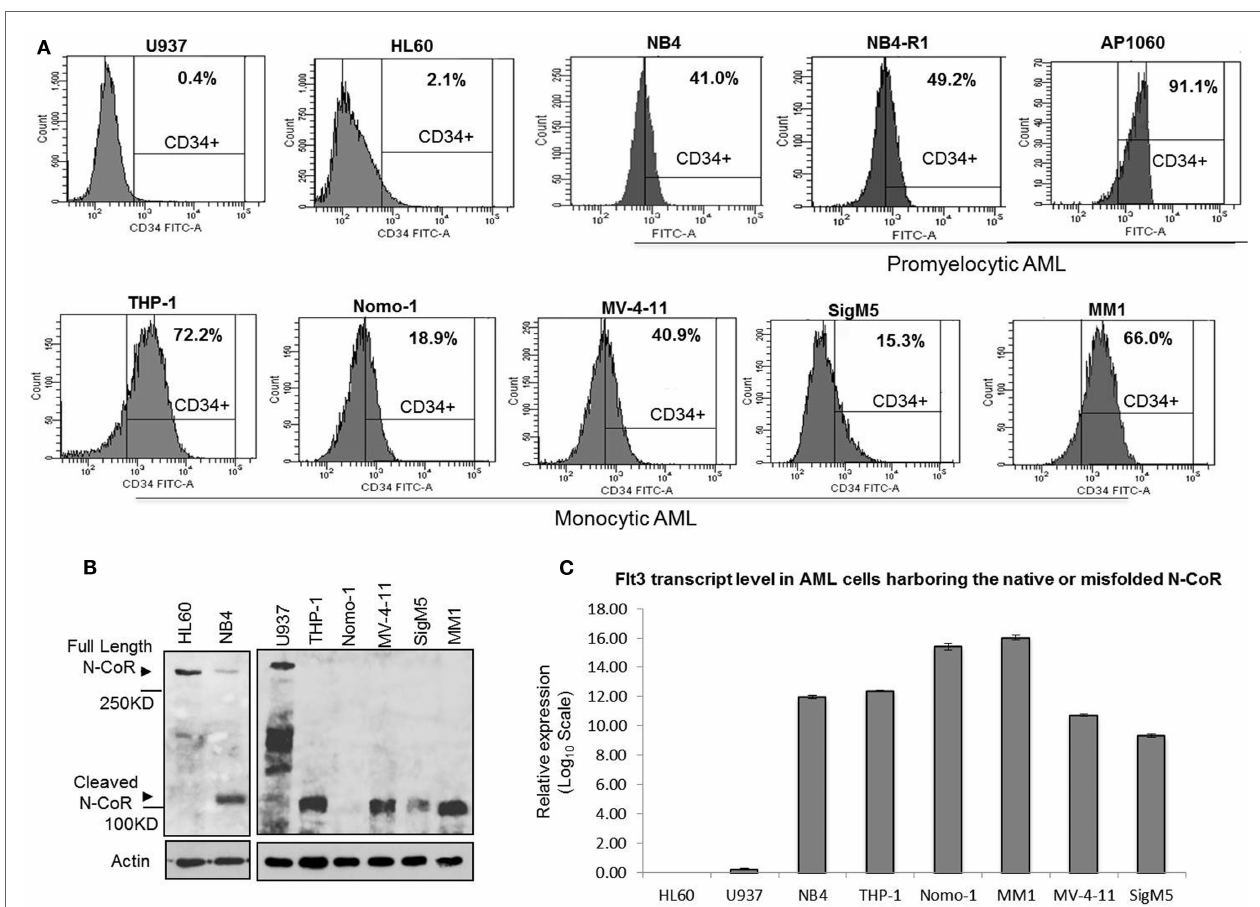
FigUre 4 | Misfolded n-cor is correlated to the cD34 + /Flt3 + -based stem cell phenotype in promyelocytic and monocytic aMl-derived cells . (a) Percentage of CD34 + cells in promyelocytic AML (NB4, NB4-R1, and AP1060) or monocytic AML (THP-1, Nomo-1, MV-4-11, SigM5, and MM1) as well as non-promyelocytic/monocytic AML cells (HL-60 and U937) as determined by flow cytometry. (B) An aliquot of whole-cell extract prepared from various AML-derived cells as mentioned on the top of each lane was resolved in SDS-PAGE and stained with anti-N-CoR antibody. All the CD34 + promyelocytic and monocytic AML cells (NB4, THP-1, Nomo-1, MV-4-11, SigM5, and MM1) harbor a distinctly misfolded N-CoR protein as demonstrated by its premature loss in Western blotting. In contrast, N-CoR in CD34-negative non-promyelocytic/monocytic AML cells (HL60 and U937) is natively folded and stable. For loading control, an aliquot of whole-cell extract was stained with residual protein beta-actin. (c) Level of Flt3 transcript in promyelocytic and monocytic AML (NB4, THP-1, Nomo-1, MV-4-11, SigM5, and MM1) and non-promyelocytic/monocytic AML cells (HL60 and U937) was determined by real-time quantitative PCR and plotted as bar graph. The values presented are average of three independent